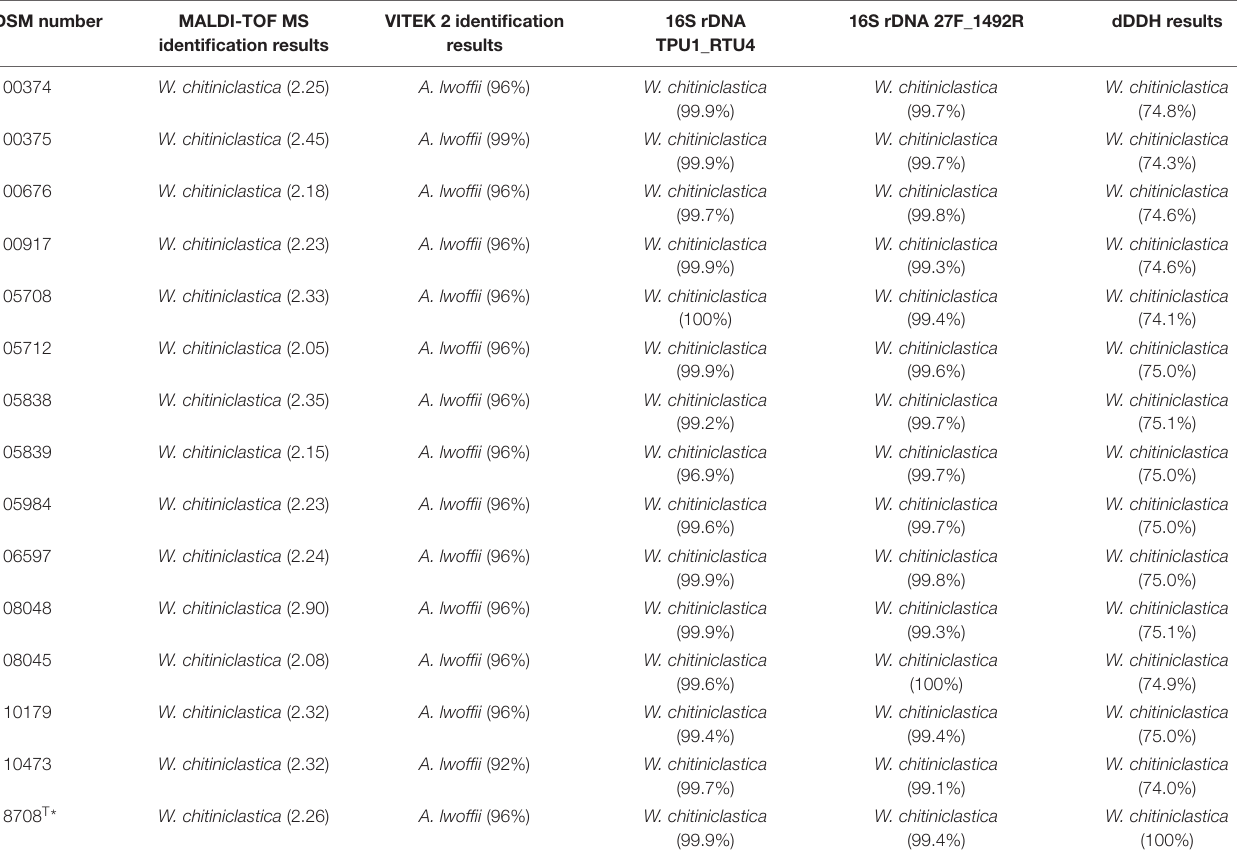
TABLE 3 | Comparison of diagnostic methods applied for identification of W. chitiniclastica. DSM